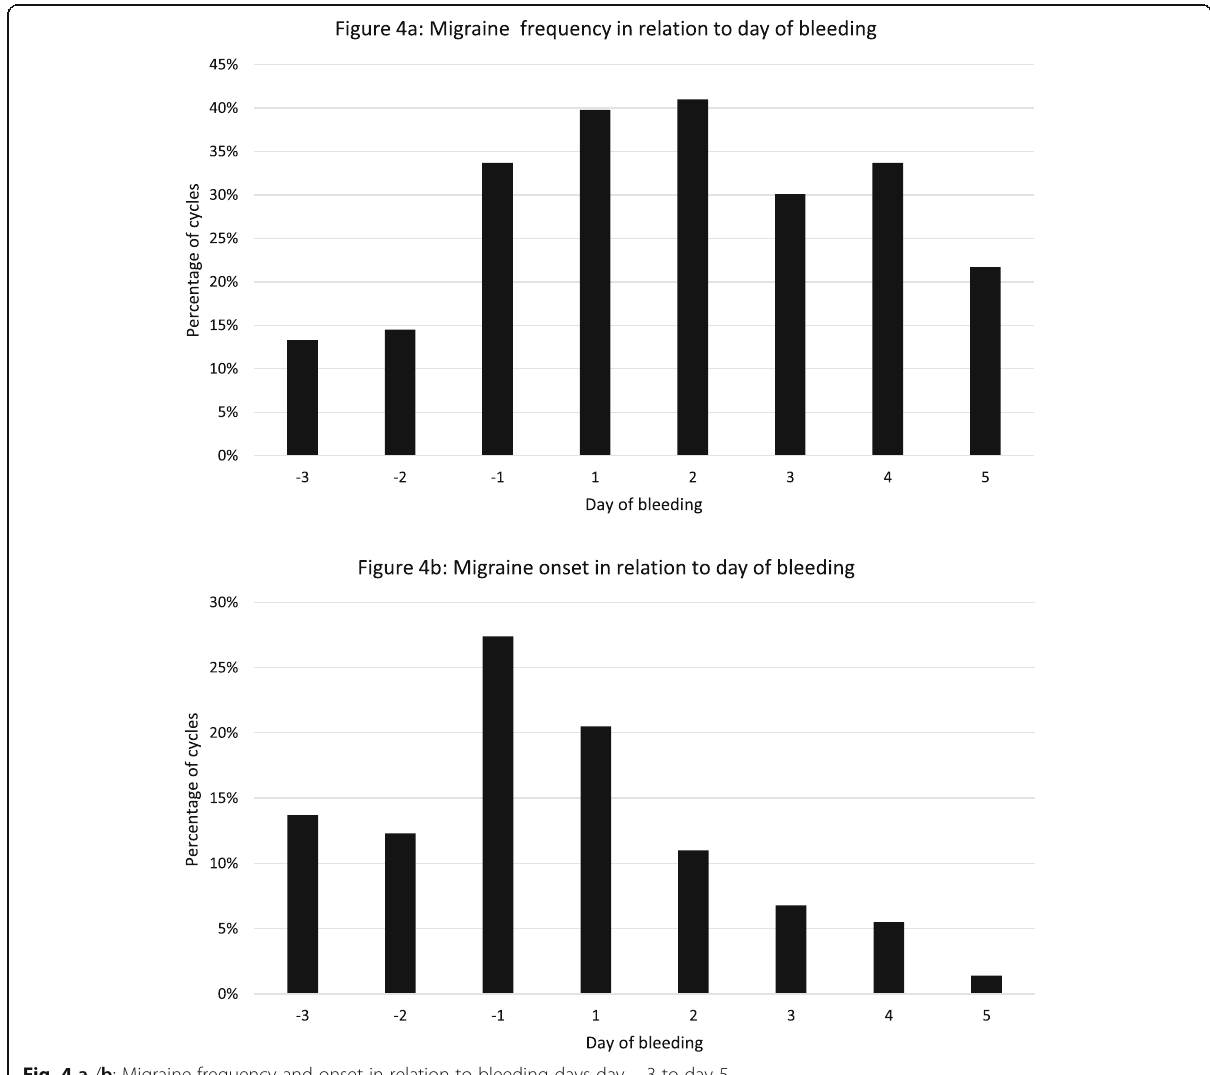
Fig. 4 a / b : Migraine frequency and onset in relation to bleeding days day − 3 to day